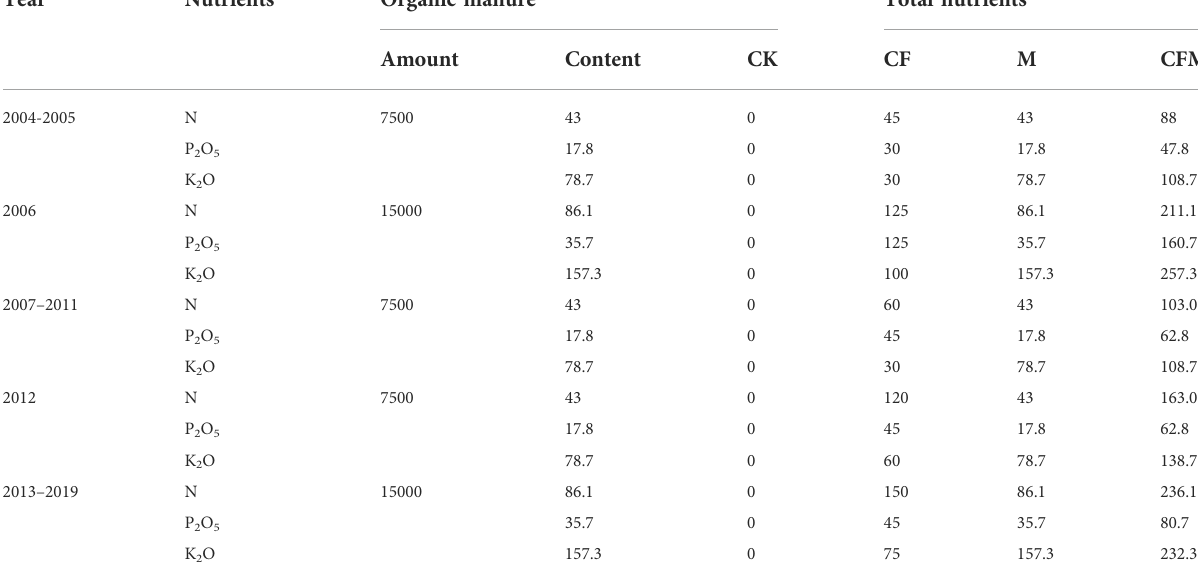
TABLE 2 Fertilizer application rates (equivalent to N, P 2 O 5 and K 2 O) in the treated plots from 2004 to 2019.